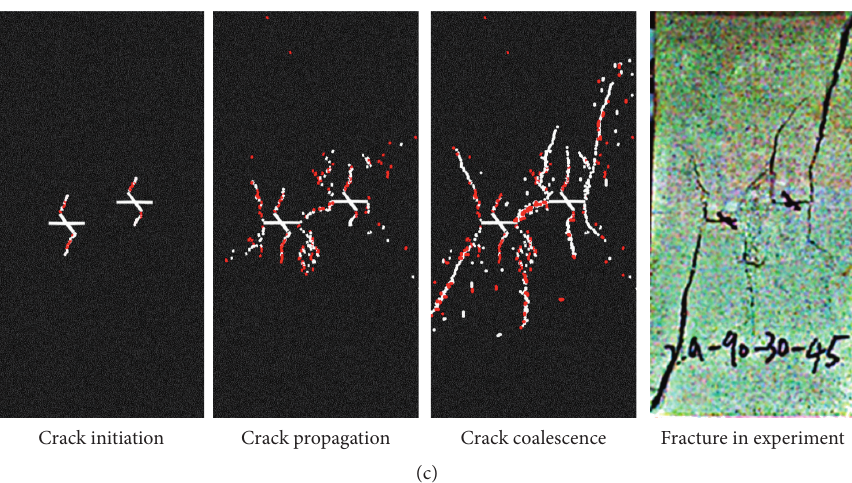
Figure 15: Diagram of crack propagation process shown by simulation results at different α values and the experimentally obtained results: